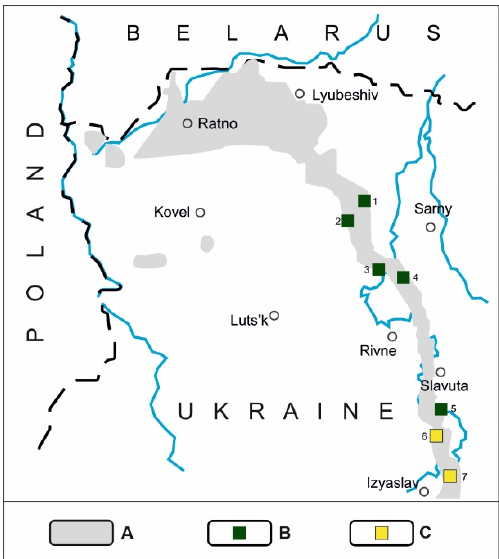
Figure 1. Location of volcanic tuffs of the Lower Vendian in the Volyn–Podilsky plate in Ukraine: A—protrusions of tuffs on the pre-Cretaceous surface; B—protrusions of tuffs on the surface in quarries (green squares): 1—Polytsi, 2—Rafalivka, 3—Ivanova Dolyna, 4—Berestovets, 5—Tashky; C—tuffs during recognition (yellow squares): 6—Varvarivka, 7—Radoshivka. Table 1. Description of the analysed samples.